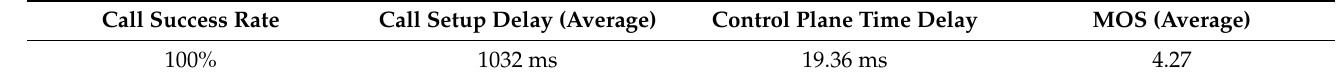
Table 4. Average Delay for VoNR to VoLTE Handover.